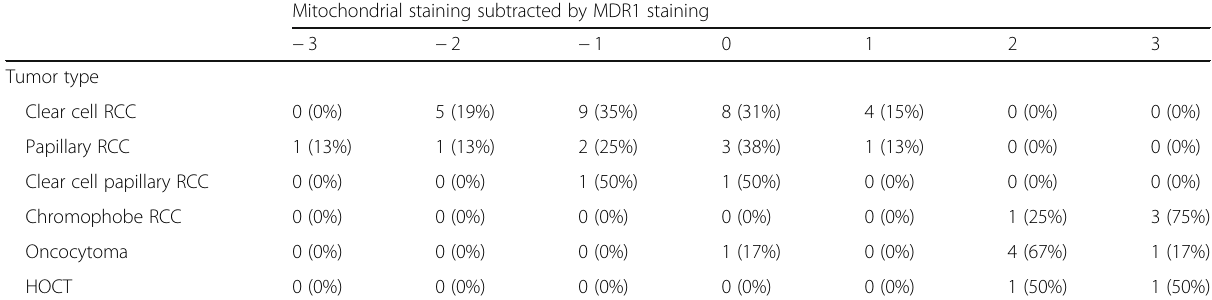
Table 3 Subtractive normalization of mitochondrial staining using MDR1 staining stratified by tumor histology Mitochondrial staining subtracted by MDR1